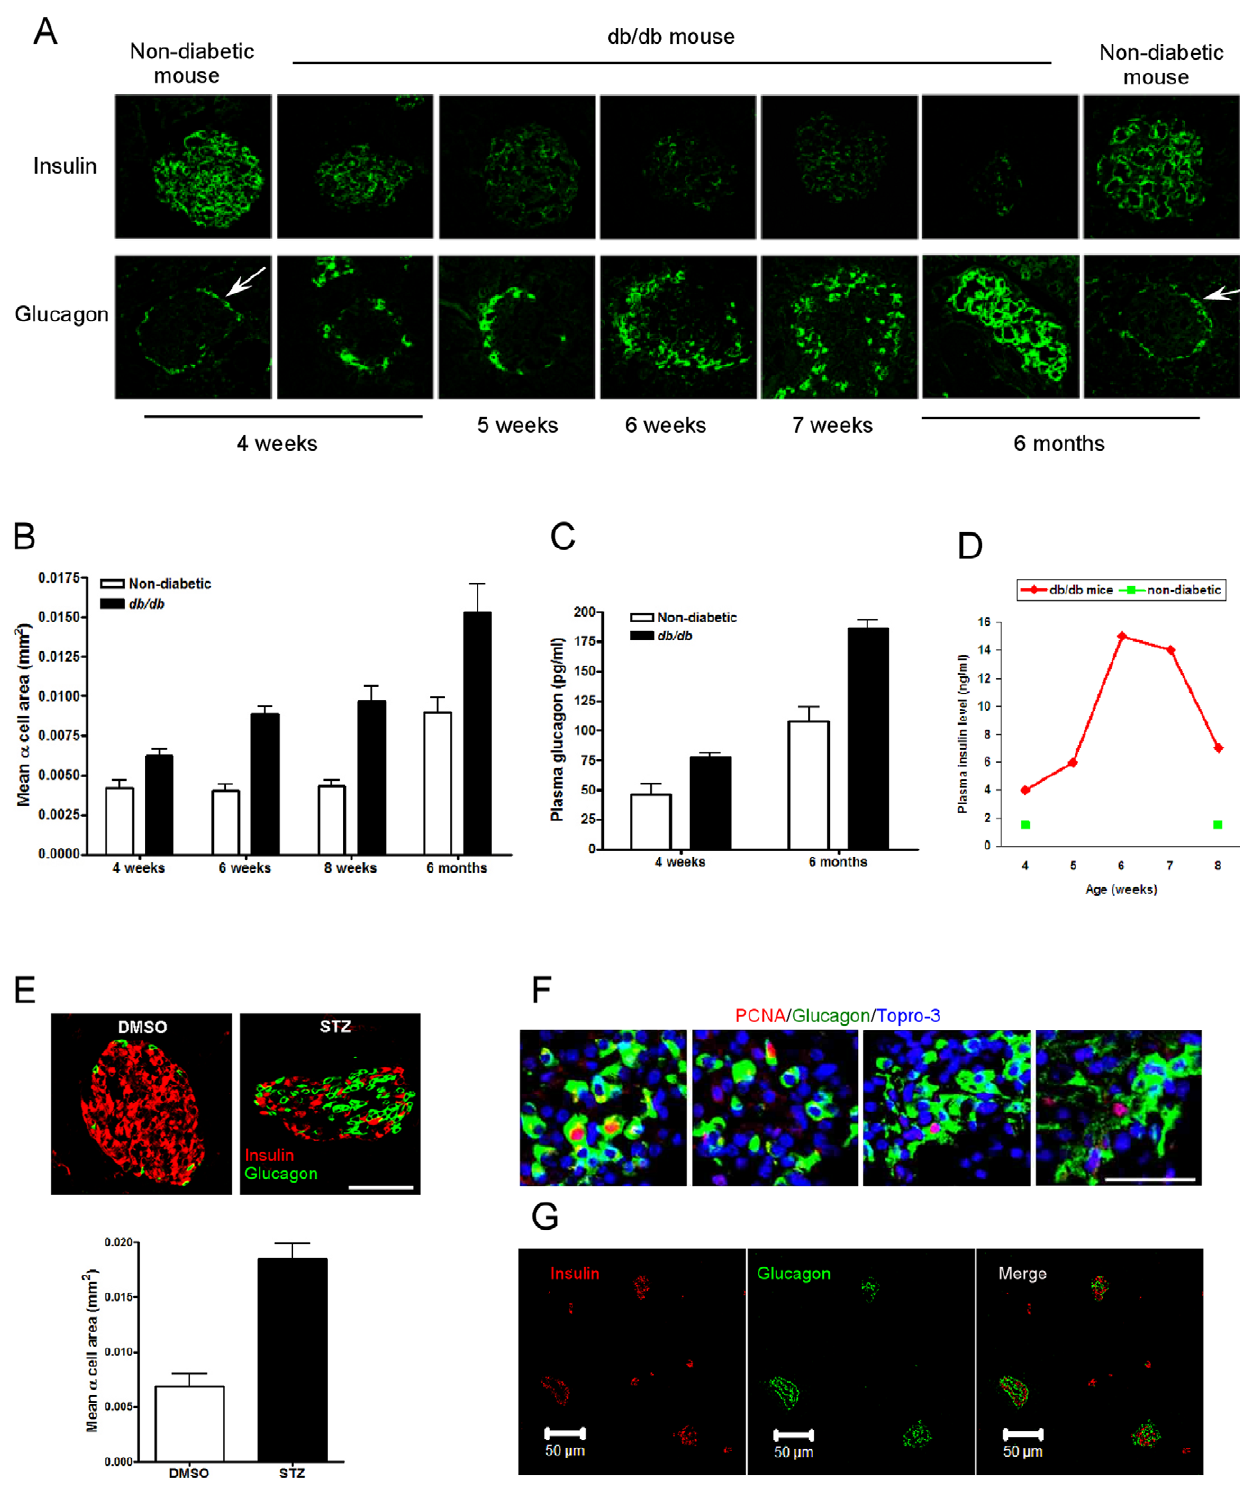
Figure 1. a -cell numbers are increased in db/db and streptozotocin (STZ)-treated mice. (A) Immunofluorescent staining of insulin and glucagon in mice at ages shown. Glucagon-positive cells are on the rim of islets in non-diabetic mice (arrows). (B) Mean glucagon-positive area in islets over time, in non-diabetic and db/db mice. (C) Random plasma glucagon levels in non-diabetic and db/db mice. (D) Random plasma insulin levels, over time, in db/db and non-diabetic mice. (E) Immunofluorescent staining of insulin and glucagon and quantification of glucagon-positive area in islets of STZ-treated CD1 mice. (F) PCNA-positive nuclei in glucagon-positive cells in islets from four different db/db mice. (G) Immunofluorescent staining of insulin and glucagon in human pancreatic paraffin sections, demonstrating lack of stereotypy in the distribution of a and b cells in human islets.